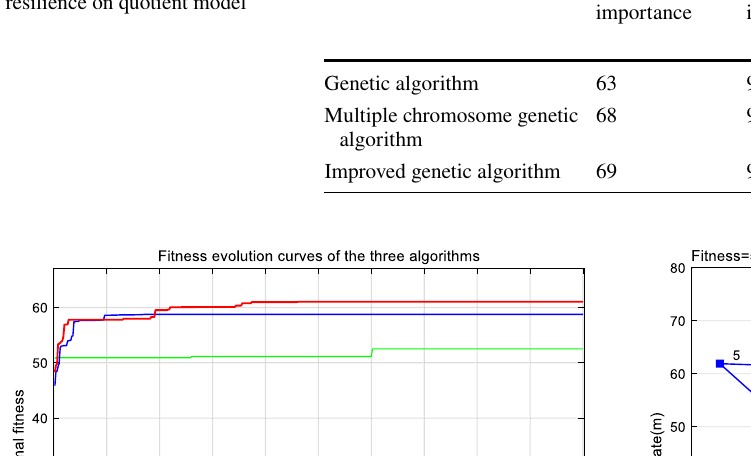
Table 7 Comparison of network